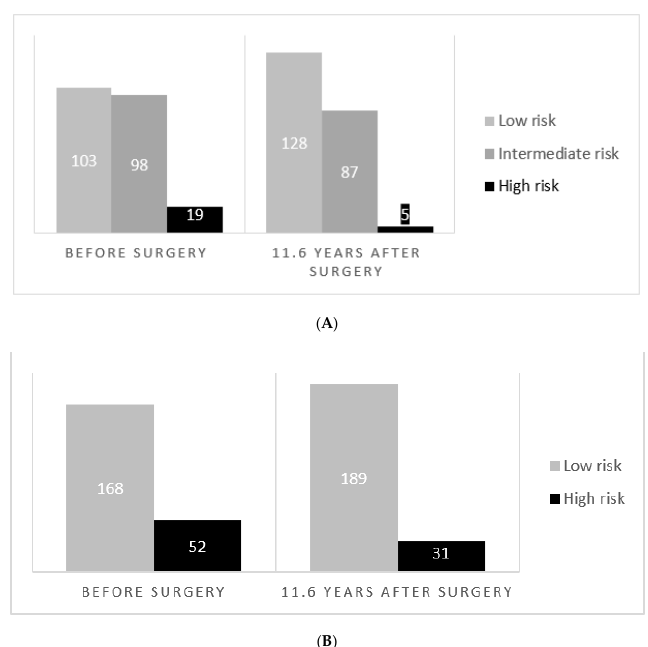
Figure 2. Risk distribution according to NAFLD fibrosis Score ( A ) and Fibrosis-4 index ( B ) before and 11.6 years after Roux-en-Y gastric bypass. 3.4. Correlation between Changes in NFS and FIB-4, Weight Loss and Remission of Type 2 Dia- betes Mellitus There was a strong correlation between changes in NFS and FIB-4 (r = 0.658, p < 0.0001) (Figure 3A). There was no correlation between change in FIB-4 and weight loss variables (%EWL (r = 0.111, p = 0.100) and %TWL (r = 0.110, p = 0.104)) and only a weak negative correlation between the decrease in NFS and weight loss (%EWL (r = −0.251, p < 0.0001) and %TWL (r = −0.280, p < 0.0001)). Similarly, there was no correlation between change in FIB-4 (r = −0.092, p = 0.172) and change in T2DM status, and the correlation between change in T2DM and change in NFS was weak but significant (r = 0.203, p = 0.003).